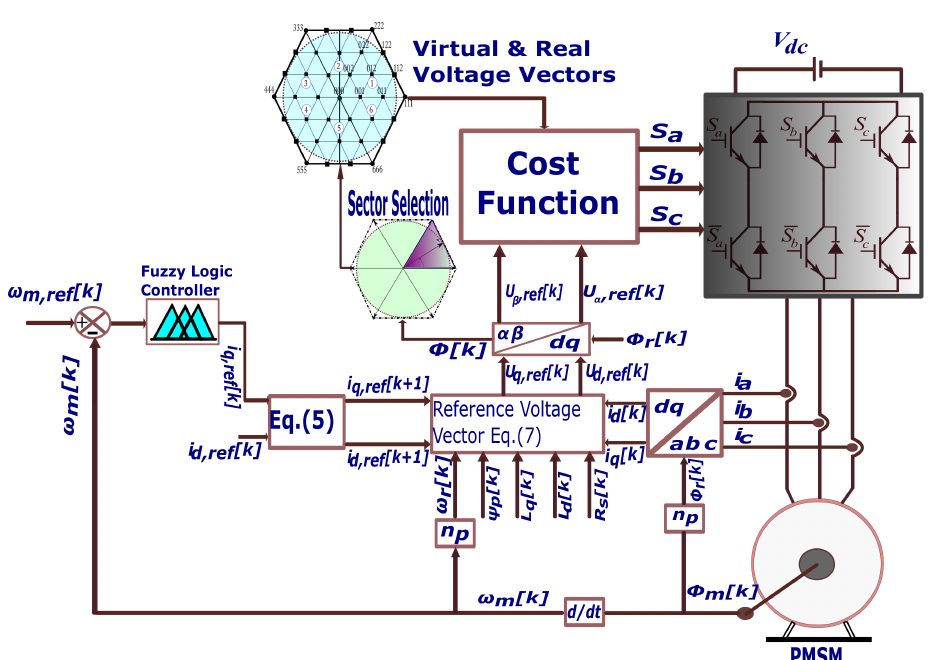
Figure 4. Proposed FCS-MPC with multiple-vector for PMSM drive